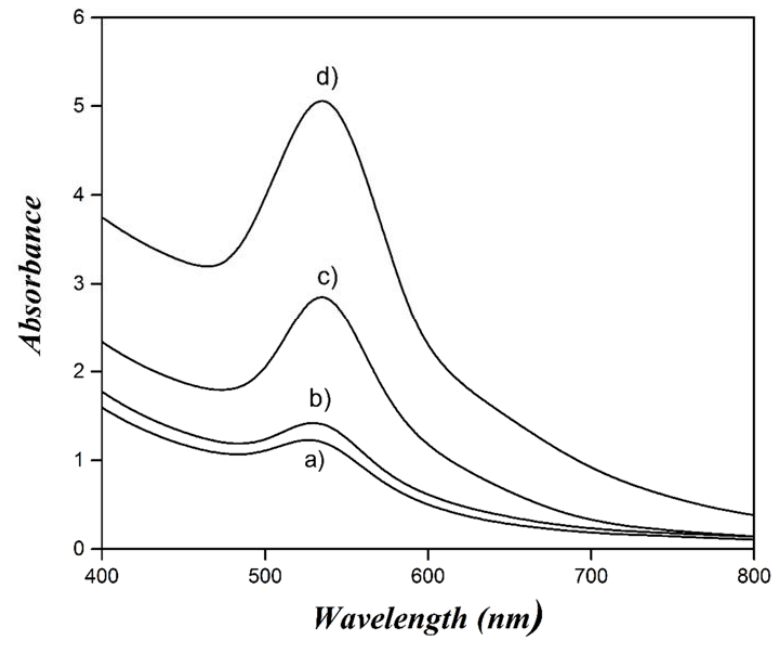
Figure 3. UV–Vis absorption spectra of AuNPs prepared at different HAuCl 4 ∙ 3H 2 O concentrations: ( a ) 0.4, ( b ) 0.7, ( c ) 1.0 and ( d ) 1.3 mM.